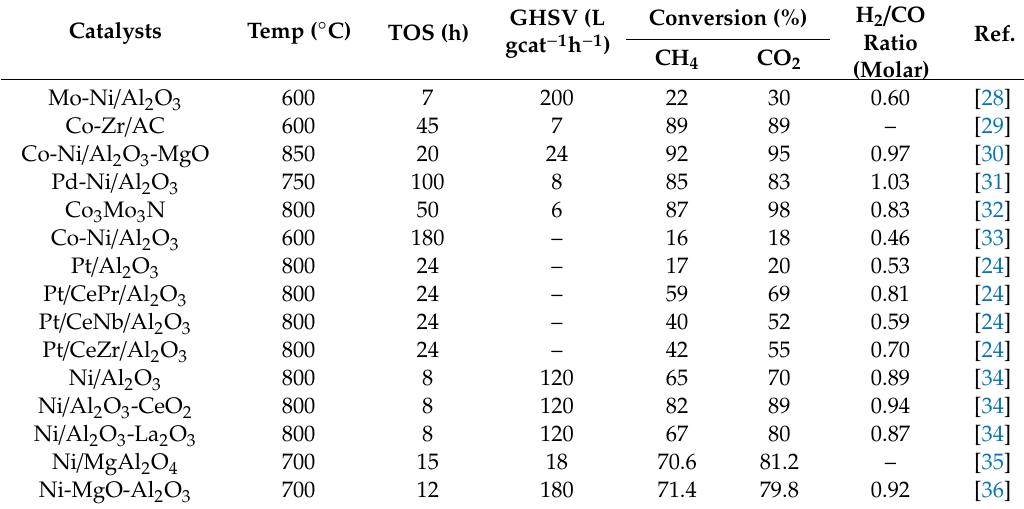
Table 1. Comparison of catalytic activity of di ff erent catalysts studied in thermo-catalytic dry reforming of methane (DRM)